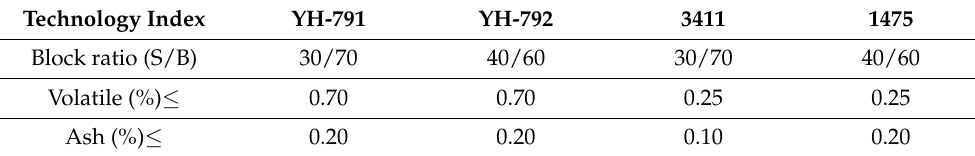
Table 2. Technical parameters of SBS modifier.